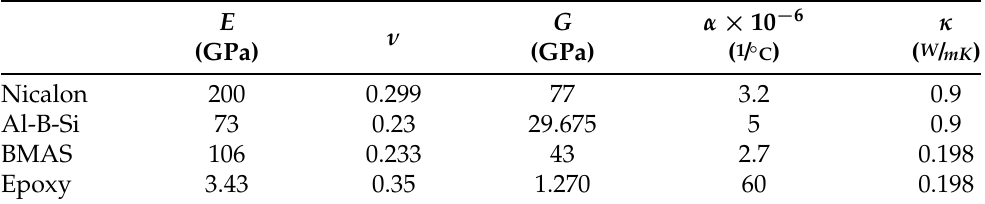
Table 2. Elastic and thermal constants of the fibers and matrices of the Nicalon/BMAS and Al-B- Si/Epoxy composite materials.